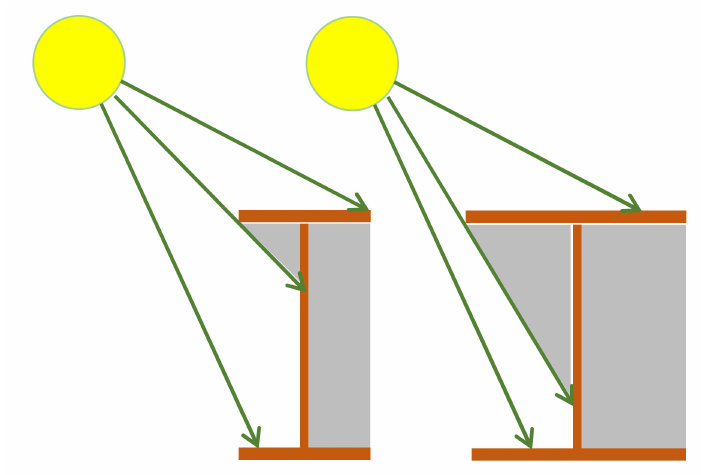
Figure 2. Effect of flange width on web